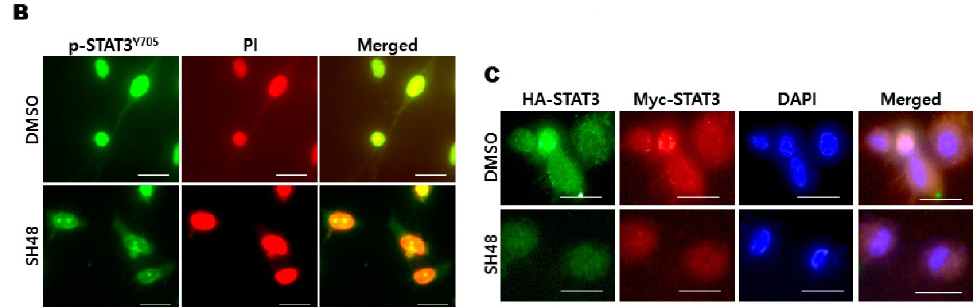
Figure 2. Effects of deguelin analogues on transcriptional activity, nuclear localization and dimerization of signal transducer and activator of transcription 3 (STAT3). ( A ) HeLa/STAT3-luc cells were pretreated with dimethyl sulfoxide (DMSO) or each of analogues (10 μ M) for 24 h, stimulated with 10 ng/mL of oncostatin M (OSM) for another 5 h, and then assayed for the luciferase reporter gene activity as described in Section 2. * p < 0.05; *** p < 0.001. ( B ) Immunocytochemical analysis was performed using p-STAT3 Y705 antibody after the treatment of MCF10A- ras cells with 10 μ M SH48 for 24 h. Cells were stained with PI and visualized by confocal microscopy. Scale bar, 50 μ m. ( C ) Immunocytochemical analysis was performed using HA-tag and Myc-tag antibodies. PC3 cells were treated with 10 μ M SH48 for 24 h. Cells were stained with DAPI and analyzed by confocal microscopy. Scale bar, 50 μ m.